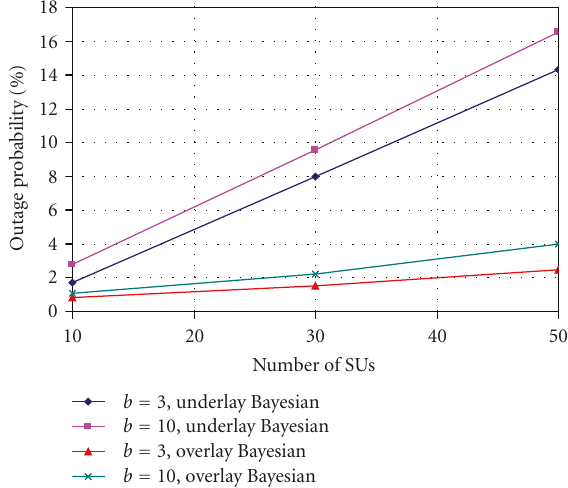
Figure 8: PUs Outage probability for overlay and underlay